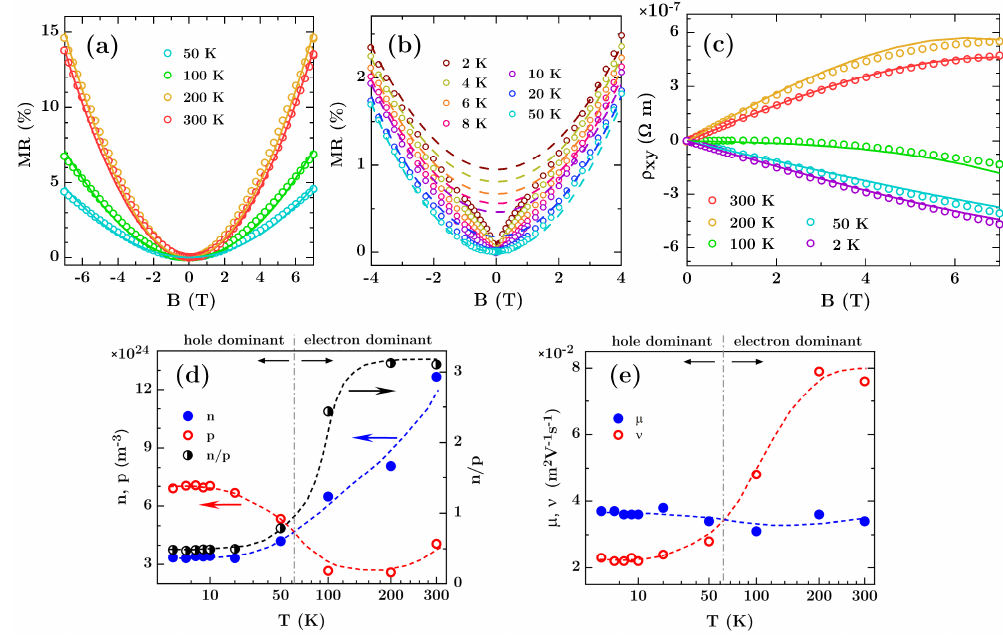
Figure 2. ( a , b ) Longitudinal magnetoresistance (MR) vs field curves and ( c ) Hall transverse resistivity dependences for the non-patterned Bi film with thickness of 50 nm. Solid and dashed lines represent theoretical curves fitted to experimental data using the two-carriers model. For clarity, the results of Hall measurements for temperature range 4 K–20 K were omitted since they are similar to those obtained at 2 K and 50 K. ( d , e ) Densities and mobilities of electrons and holes derived from the fitting. The right scale of graph ( d ) is related to the n/p ratio.